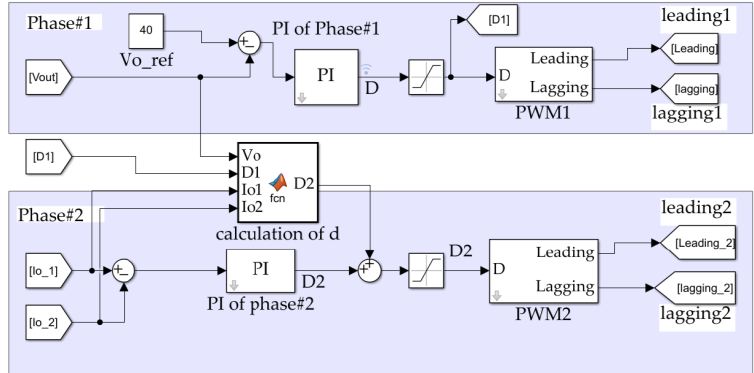
Figure 13. Controller part of simulation model.